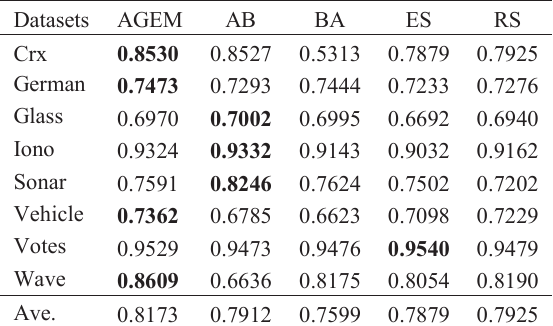
Table 2. Performance of AGEM and other ensemble algorithms